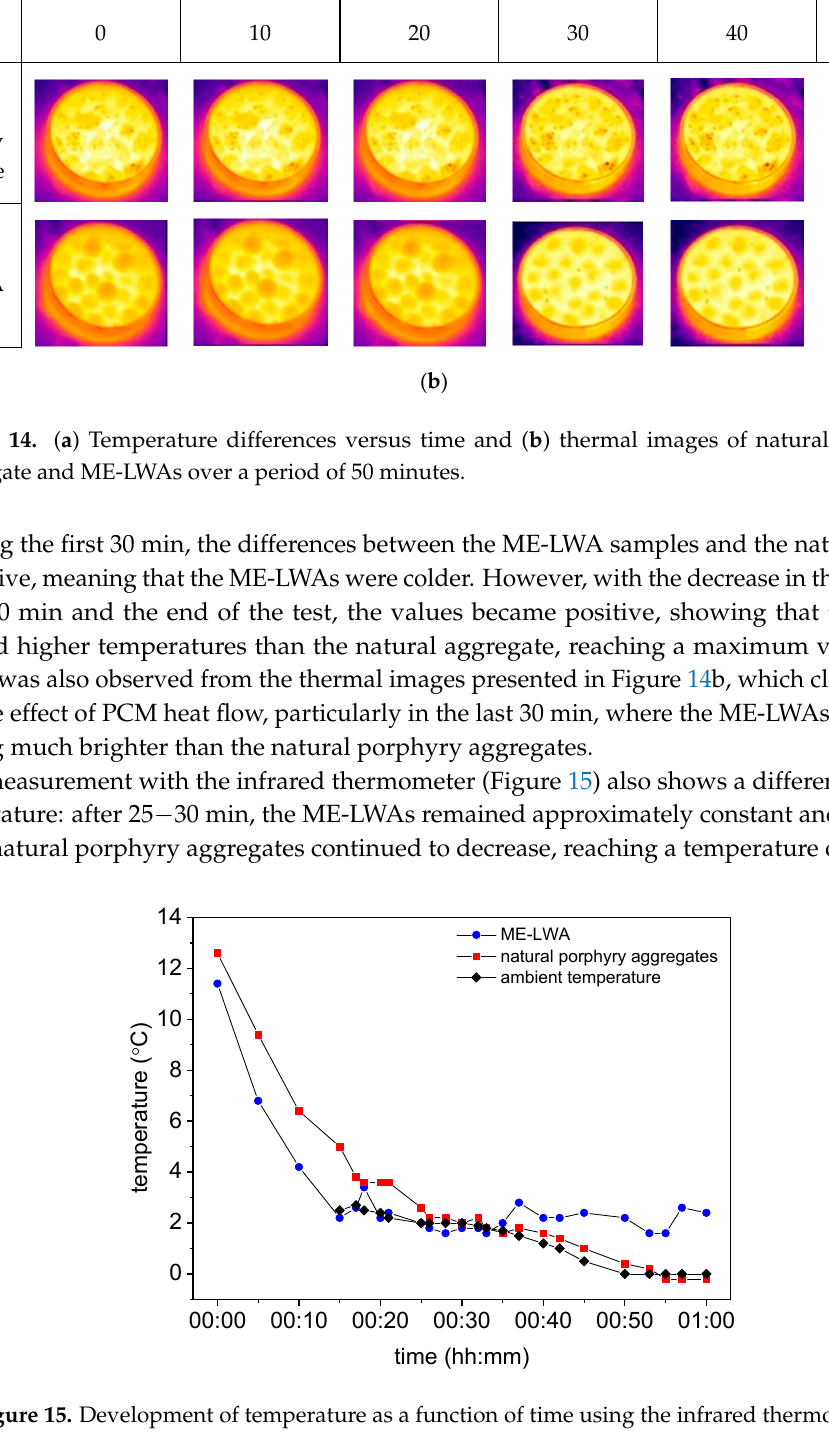
Figure 15. Development of temperature as a function of time using the infrared thermometer.